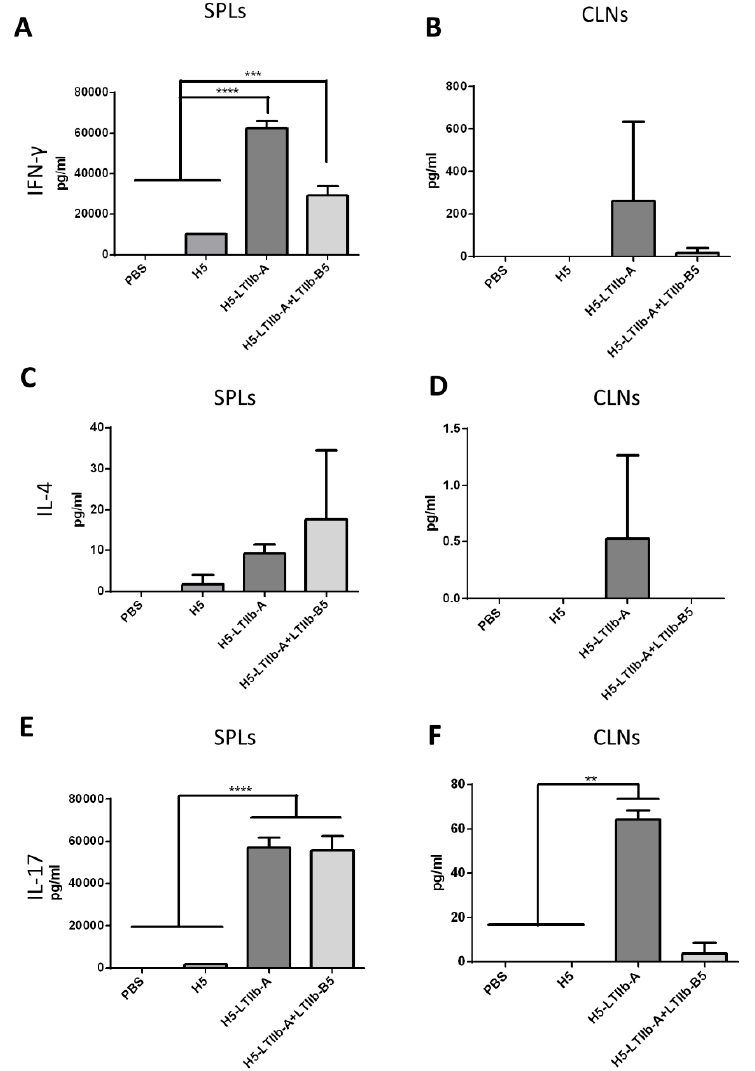
Figure 4. T cell responses elicited by intranasal immunizations with H5-LTIIb-A fusion protein. Groups of BALB / c mice were immunized with phosphate bu ff ered saline (PBS), H5 protein (H5), H5-LTIIb-A fusion protein (H5-LTIIb-A), or the combination of H5-LTIIb-A fusion protein and another LTIIb-B5 subunit protein (H5-LTIIb-A + LTIIb-B5). The levels of IFN- γ -secreted cytokine by the H5-stimulated T cells from spleen (SPLs) and cervical lymph nodes (CLNs) ( A,B ); the levels of IL-4-secreted cytokine by the H5-stimulated T cells from SPLs and CLNs ( C,D ); the levels of IL-17A-secreted cytokine by the H5-stimulated T cells from SPLs and CLNs. Statistical significance was expressed as * p < 0.05; ** p < 0.01; *** p < 0.001; **** p < 0.0001.